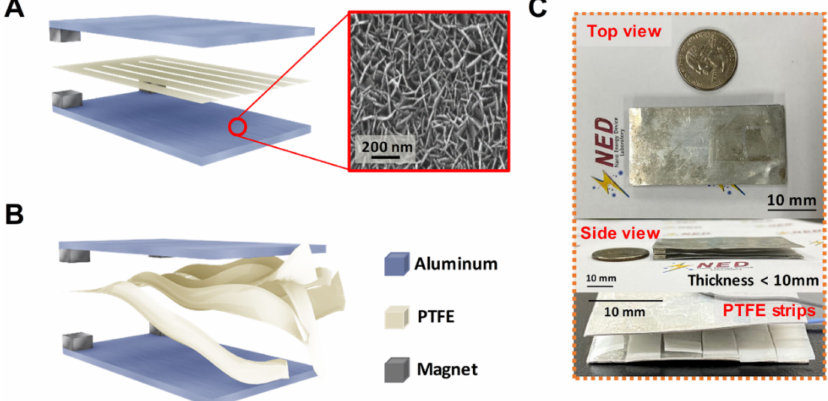
Figure 1. ( A ) Schematic diagram of the wind-TENG with SEM image showing the surface of Al electrode treated by WAO process. ( B ) Wind-TENG with the PTFE strips fluttering when the wind in injected. ( C ) The optical images of the wind-TENG taken from top view, side view and displaying the structure PTFE